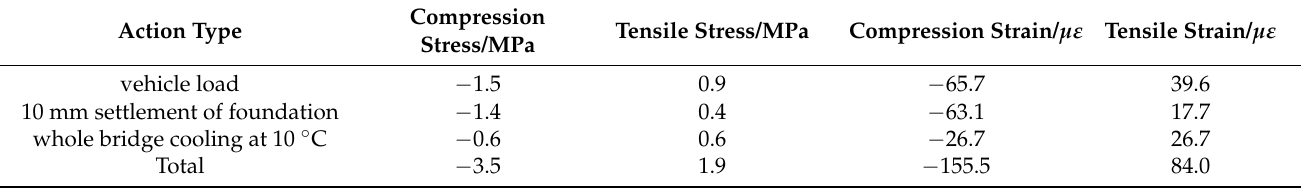
Table 7. Finite element static analysis results of the maximum stress and strain of the arch